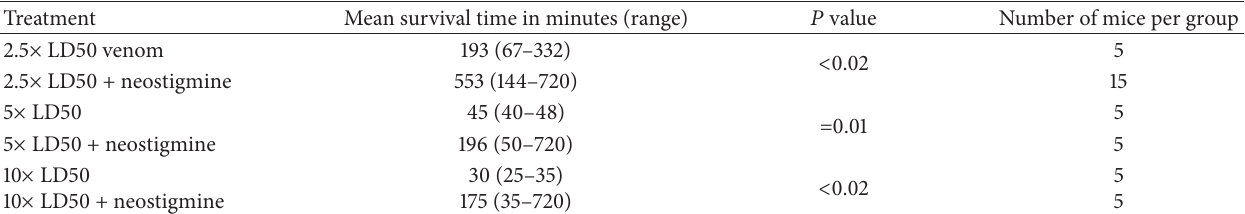
Table 1: Survival times for all venom dosages compared with and without IN neostigmine treatment. 𝑃 values shown were as calculated by nonparametric Mann-Whitney